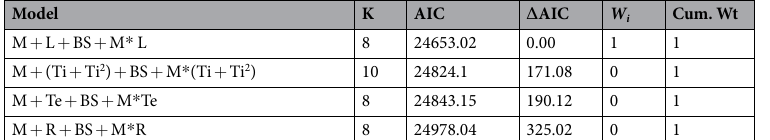
Model K AIC Cum. Wt